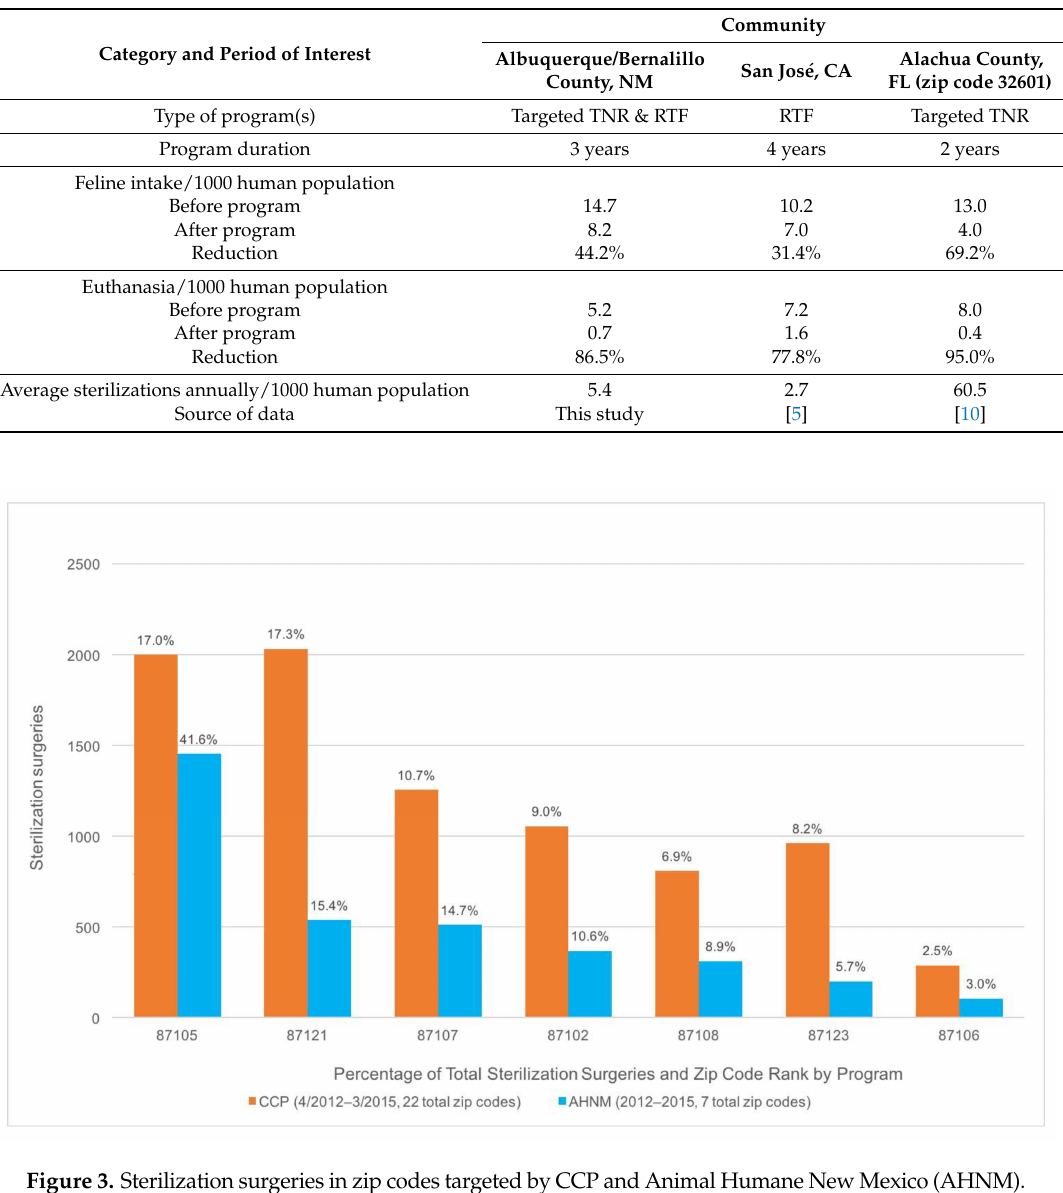
Figure 3. Sterilization surgeries in zip codes targeted by CCP and Animal Humane New Mexico